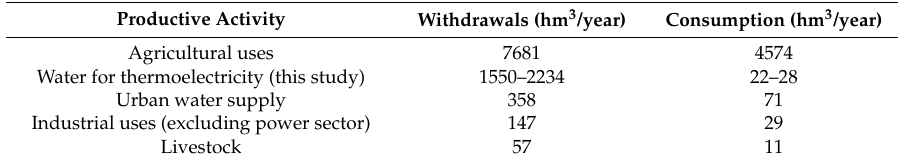
Table 3. Comparison between water withdrawals and consumption by type of productive activity in the Ebro River basin,